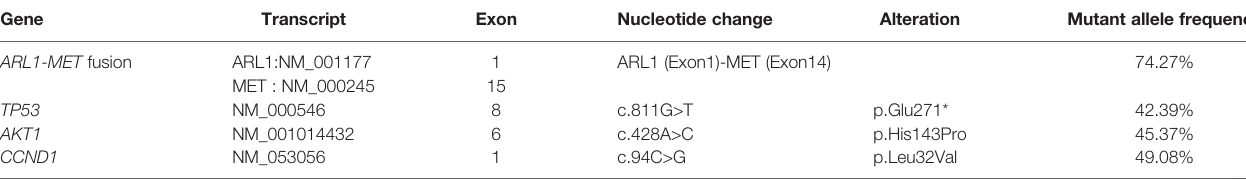
TABLE 1 | Mutation pro fi le of right lung tumor in the patient before treatment with crizotinib. Gene Transcript Exon Nucleotide change Alteration Mutant allele frequency